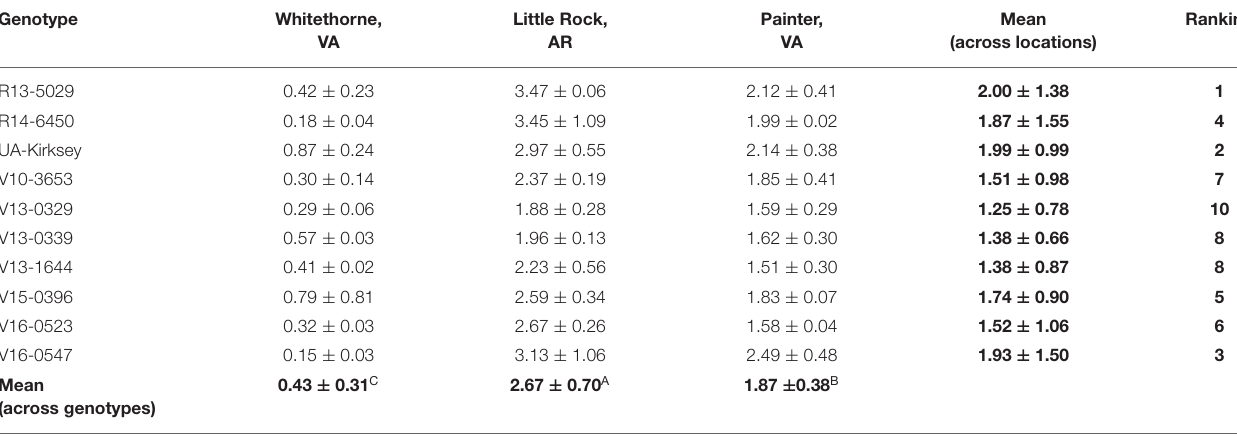
TABLE 3 | Alanine contents (mg/g dry matter) of 10 edamame genotypes planted in three locations. Genotype